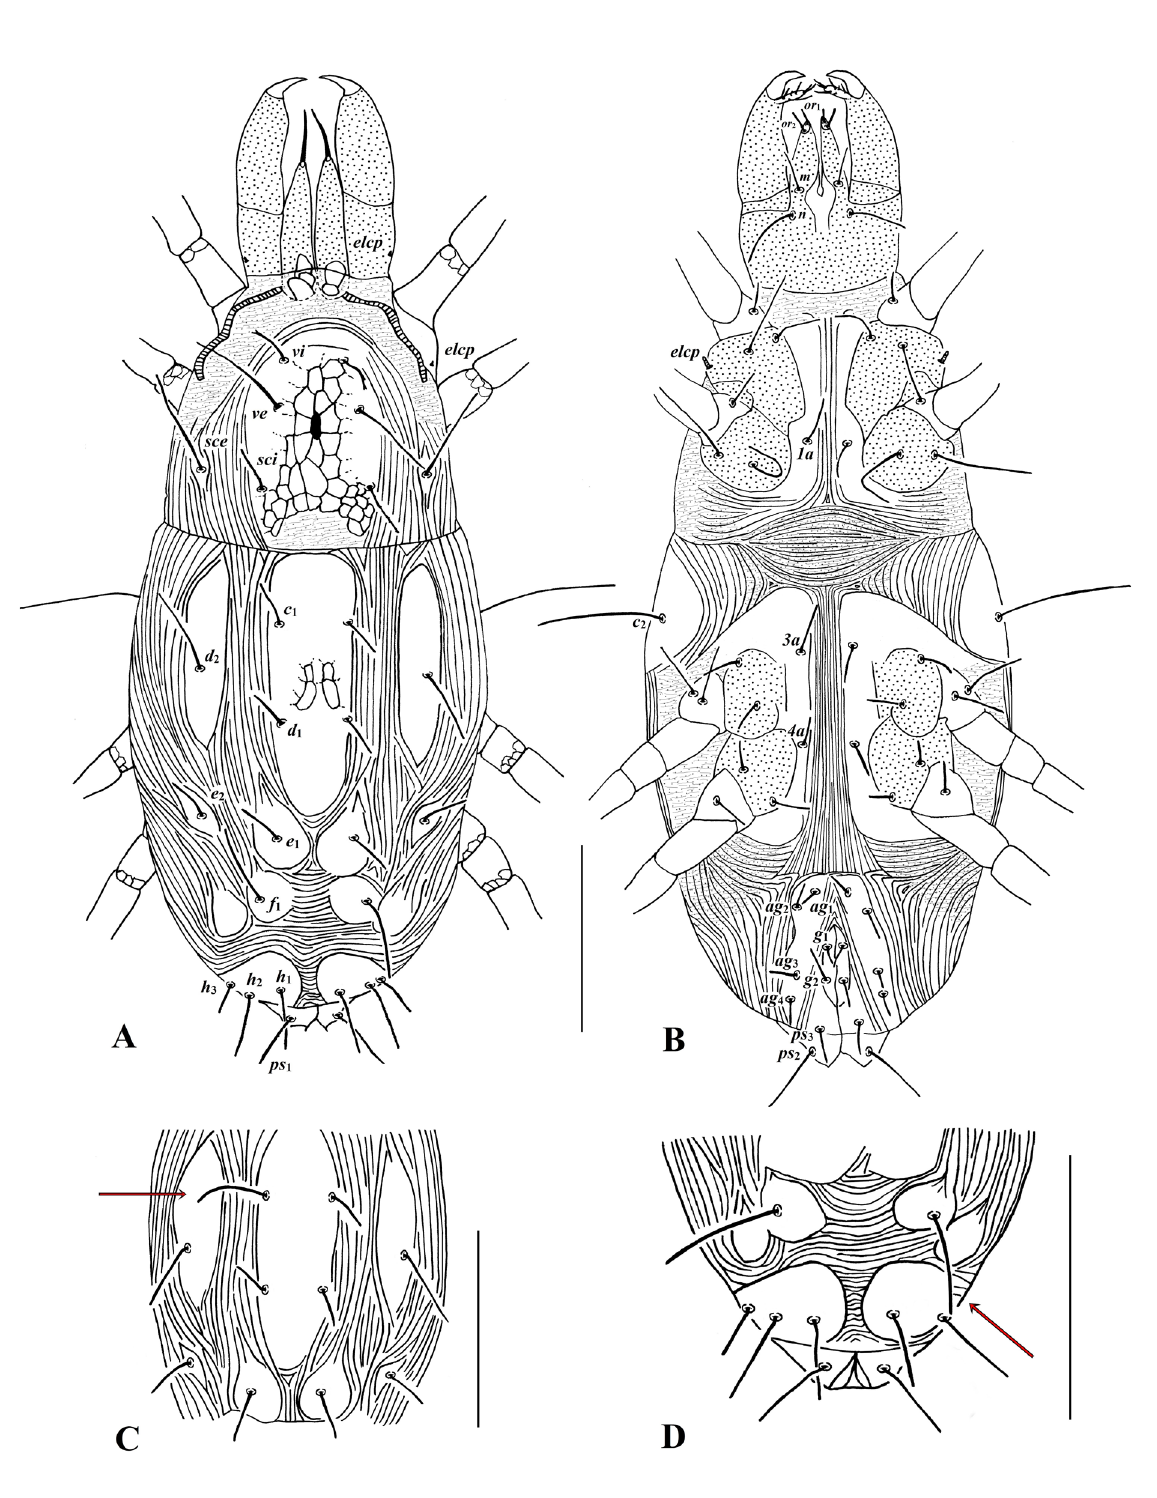
Fig. 1. Stigmaeus bifurcus sp. nov. A–B . Holotype (♀). A . Dorsum of body. B . Venter of body. – C–D . Paratype (♀). C . Abnormality: left seta c h absent on right suranal shield in one paratype. Scale bars = 100 3